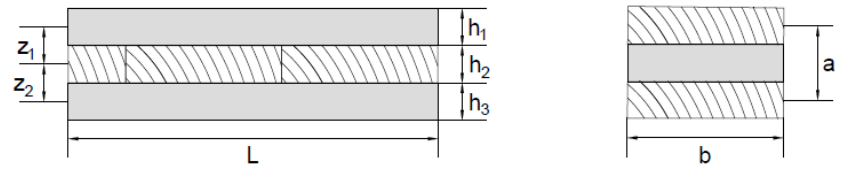
Figure 1. Typical section of a three-layered cross-laminated timber (CLT).